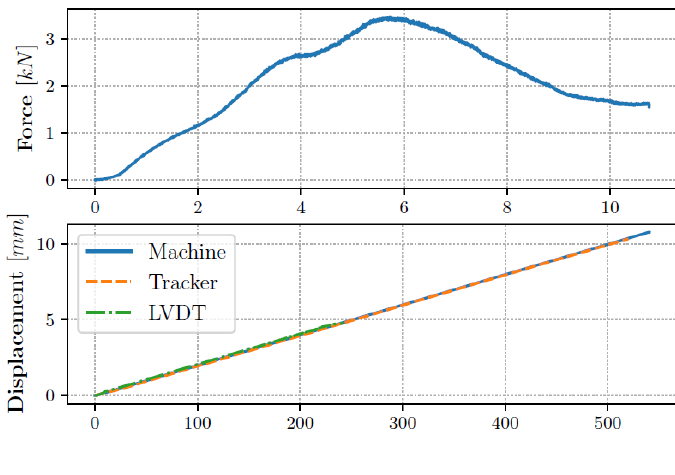
Figure 4: Force-displacement and displacement-time example curves obtained in the quasistatic compression